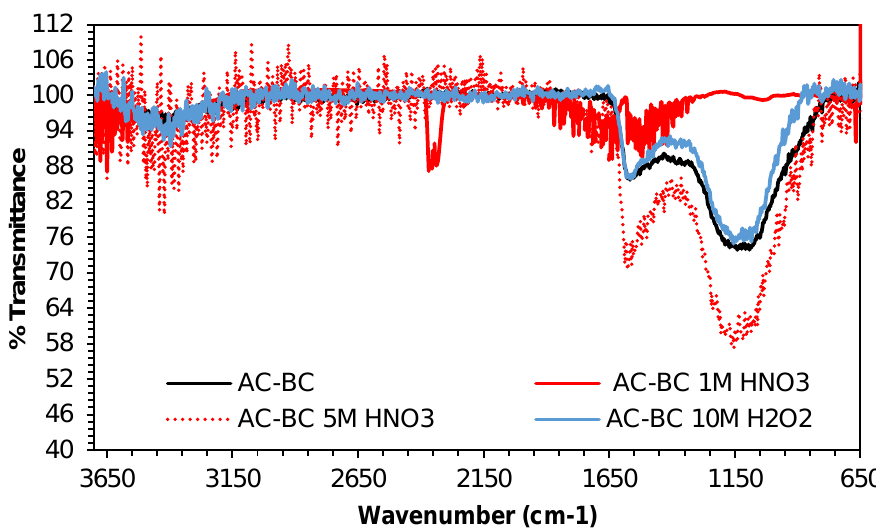
Figure 7. FTIR Spectra for AC-BC untreated, nitric treated, and peroxide treated. The stretching and vibration peak caused by C=O around 1665 cm − 1 (indicative